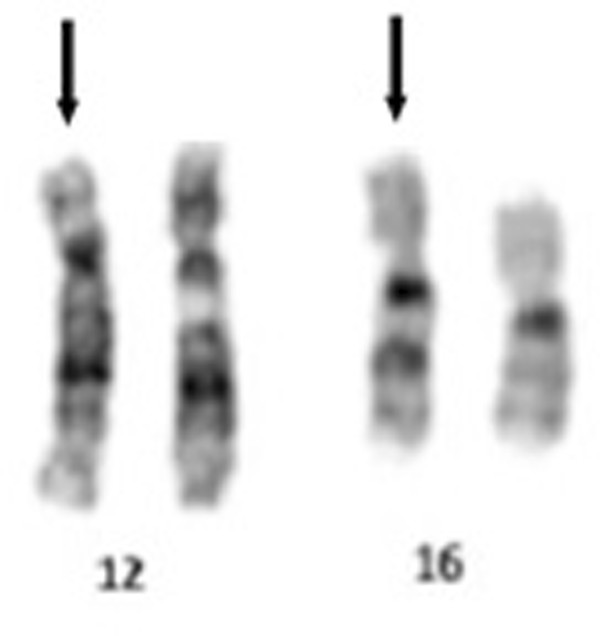
G-Banding image of rearranged chromosomes 12 and 16. G-Banded karyotype shows a pericentric inversion, from band p12 to q13, on one chromosome 12, an interstitial deletion of the region from 12q14 to 12q21 and additional material on one chromosome 16, within the bands q21q22. Arrows mark the derivative chromosomes.